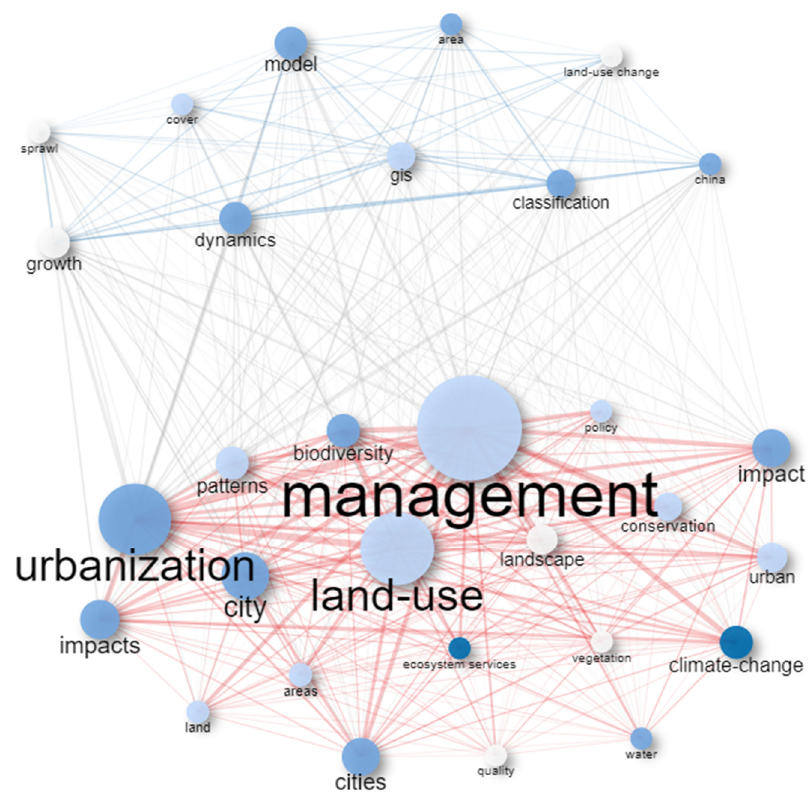
Figure 10. Keyword Co-occurrence Network Analysis (Top 30).